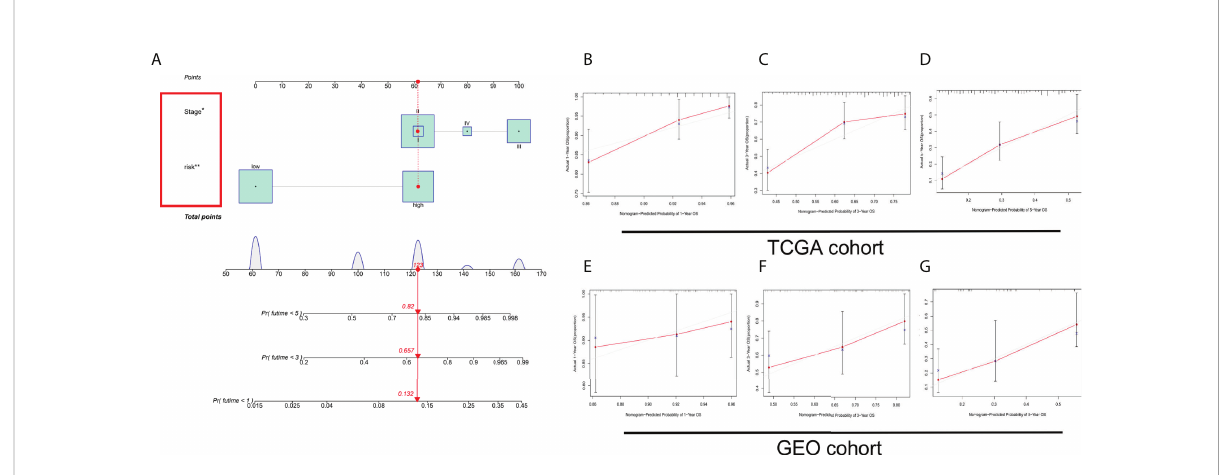
FIGURE 7 Establishment and veri fi cation of a nomogram. (A) Nomogram for forecasting the total survival (OS) of patients with ESCC at 1, 3, and 5 years. Calibration curves of nomogram for OS forecast at 1, 3, and 5 years in (B – D) TCGA and (E – G) GEO cohorts. * P <0.05, ** P <0.01.